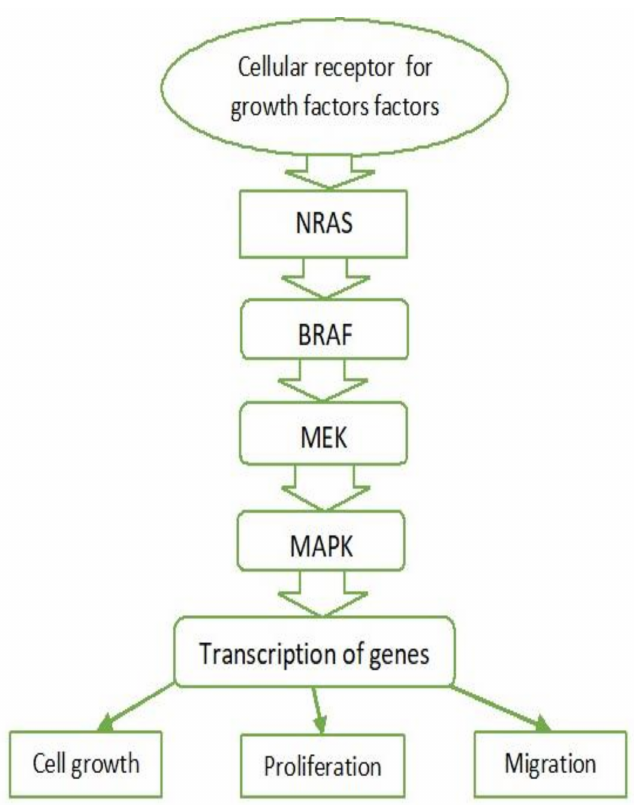
Figure 2. MAPK pathway. NRAS—Neuroblastoma RAS viral oncogene homolog. BRAF—v-Raf murine sarcoma viral oncogene homolog B. MEK—Mitogen-activated protein kinase kinase. MAPK— Mitogen-activated protein